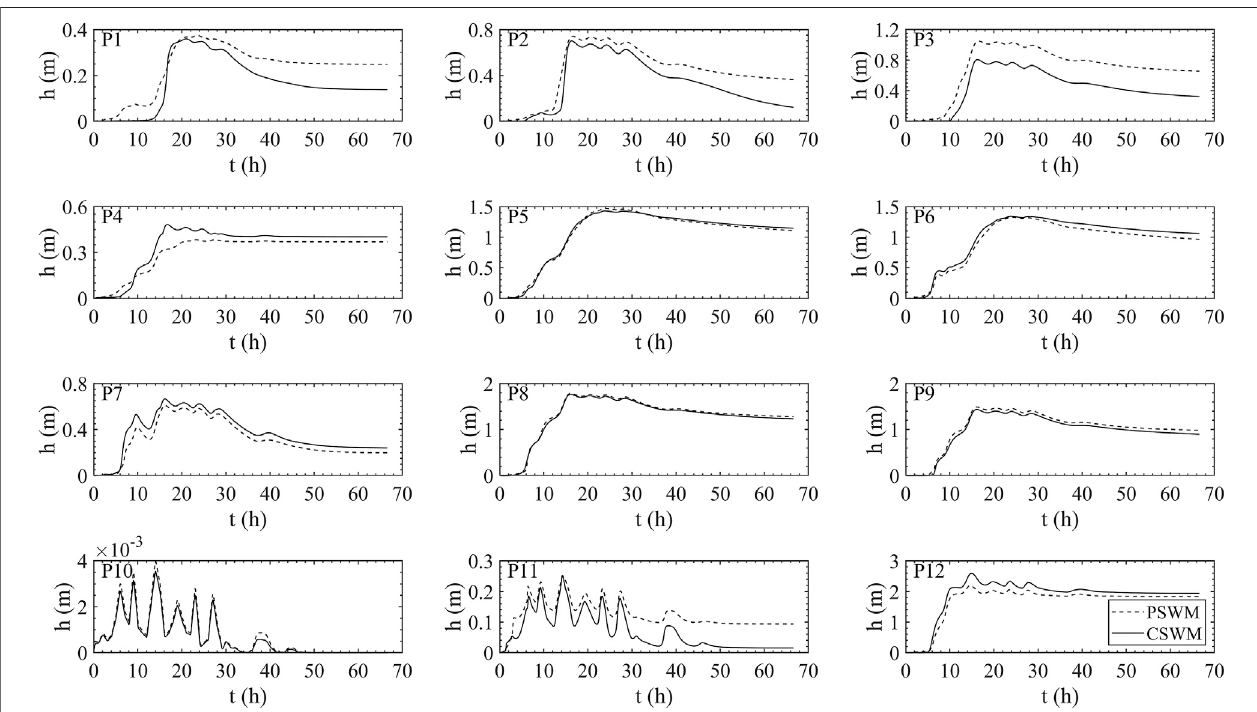
FIGURE 7 | Temporal evolution of water depth at 12 selected points for PSWM and CSWM.